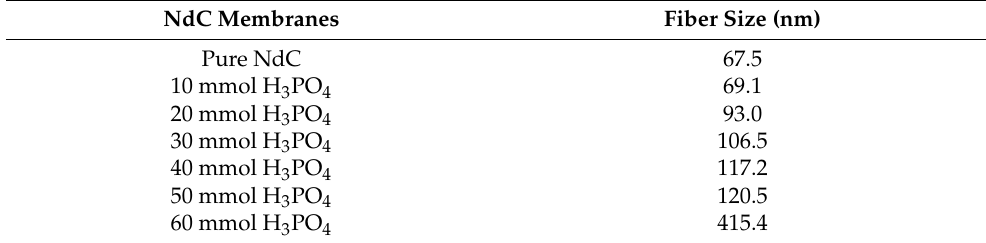
Table 1. Fiber size (diameter) of phosphorylated Nata de Cassava membranes.